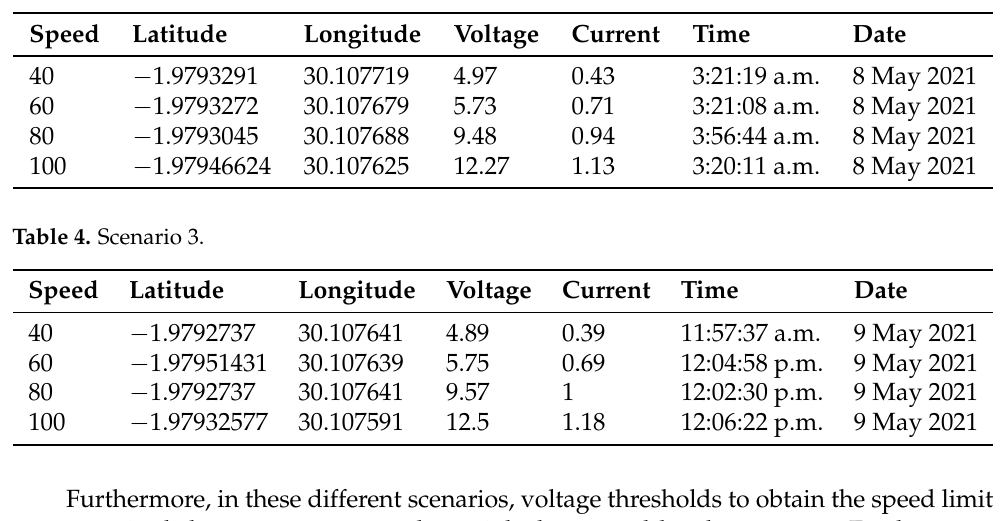
Table 3. Scenario 2.